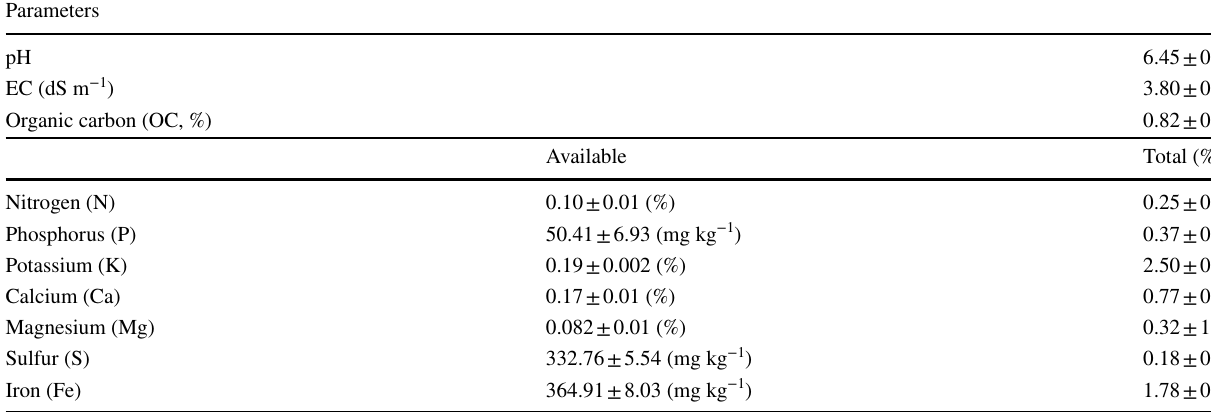
Table 1 Some properties of soil